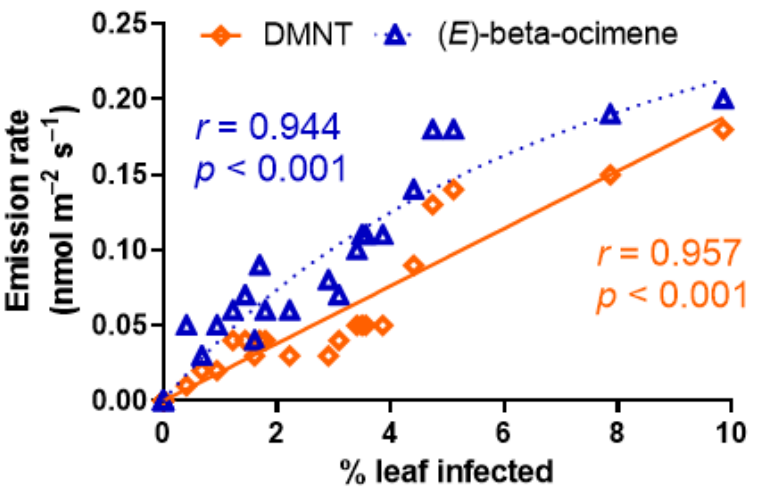
Figure 6. Correlations of the emission rates of the homoterpene 3-( E )-4,8-dimethyl-1,3,7-nonatriene (DMNT) and the monoterpene ( E )-β-ocimene with the percentage of A. erinea infection in J. regia leaves ( n = 25). Environmental conditions during the measurements as in Figure 2. The data have been fitted using non-linear regression y = a x/(b + x).